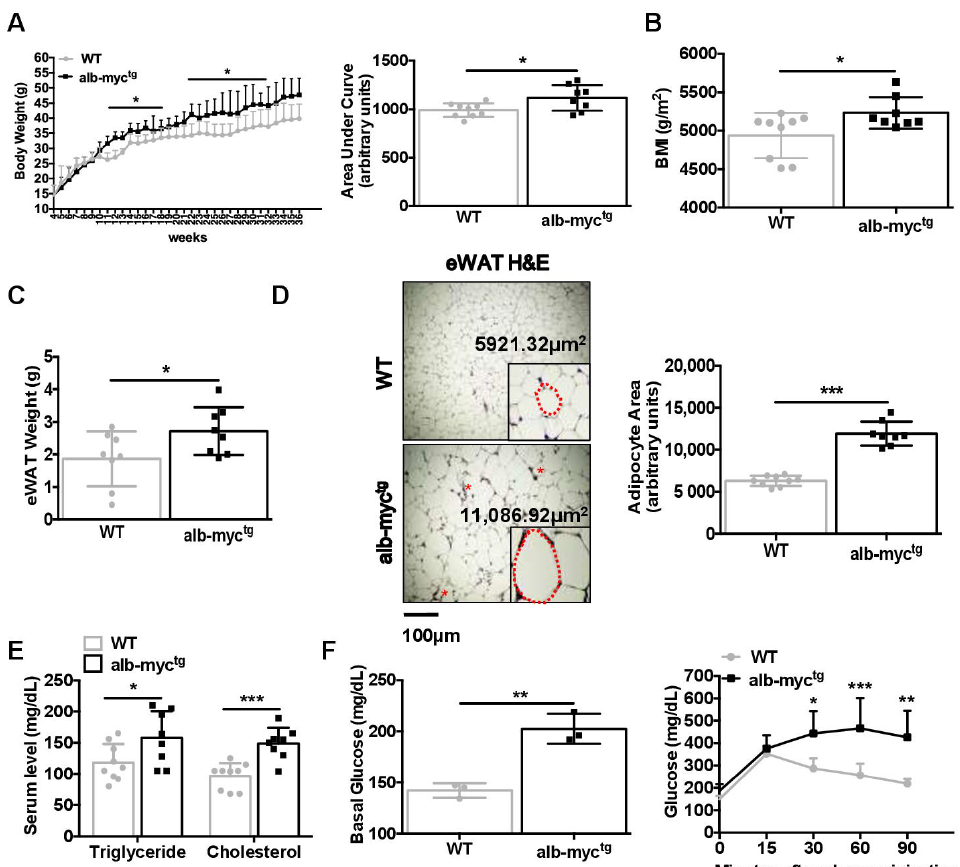
Figure 2. Metabolic profile of chow diet-fed alb-myc tg mice at the age of 36 weeks. ( A ) Left: Growth curve demonstrating body weight gain, assessed at 7 days’ interval for each group. Right: The histogram represents the incremental area under the respective grow curve ( n = 8–9). ( B ) Body mass index (BMI) (g/m 2 ) ( n = 8–9). ( C ) Weight of epididymal white adipose tissue (eWAT) ( n = 8). ( D ) Size of eWAT cells by H&E staining. Scale bar = 100 µ m. Size of individual cells from both groups was measured and average cell size ( µ m 2 ) was quantified ( n = 8–9). Asterisks indicate CLS. The dotted red line marks the individual adipocyte. ( E ) Levels of cholesterol and TG in serum ( n = 8–9). ( F ) Basal glucose level in blood after 6 h fasting; Blood glucose concentration curve during intraperitoneal glucose tolerance test ( n = 3). Data are expressed as the mean ± SD, * = p < 0.05; ** = p < 0.01, *** = p < 0.001, alb-myc tg mice vs. WT controls.